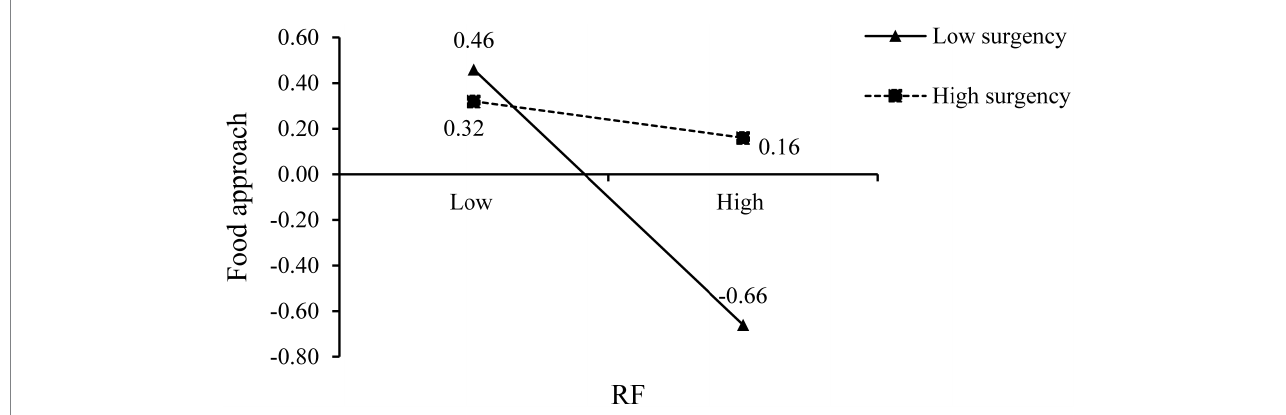
FIGURE 1 The plot of the relationship between RF and food approach at two levels of surgency. RF, Responsive Feeding. The significant path is represented by the solid line, whereas the non-significant path is represented by the dotted